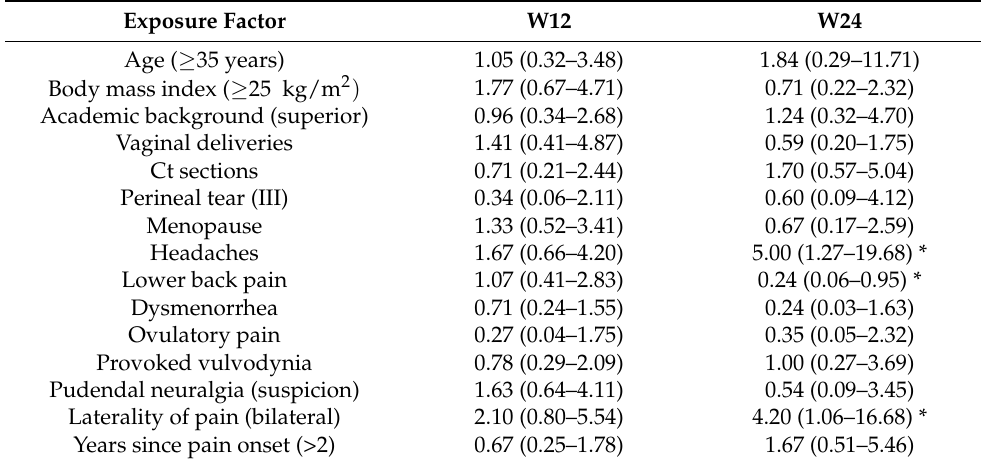
Table 2. Risk ratio (95 percent confidence interval) at Weeks 12 (W12) and 24 (W24) of the study when each clinical characteristic was considered as the exposure factor. (*): p value (Test 2) < 0.05.